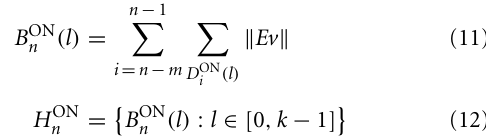
Algorithm 1 | Pseudo code for the laser stripe